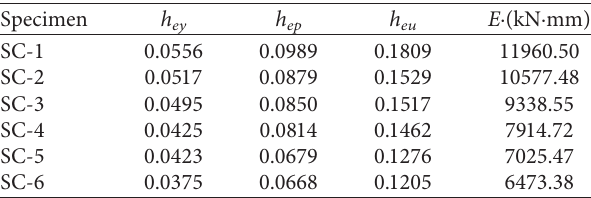
Figure 11: Calculation diagram of the equivalent viscous damping coefficient. Table 7: Hysteretic energy dissipation indicators of the